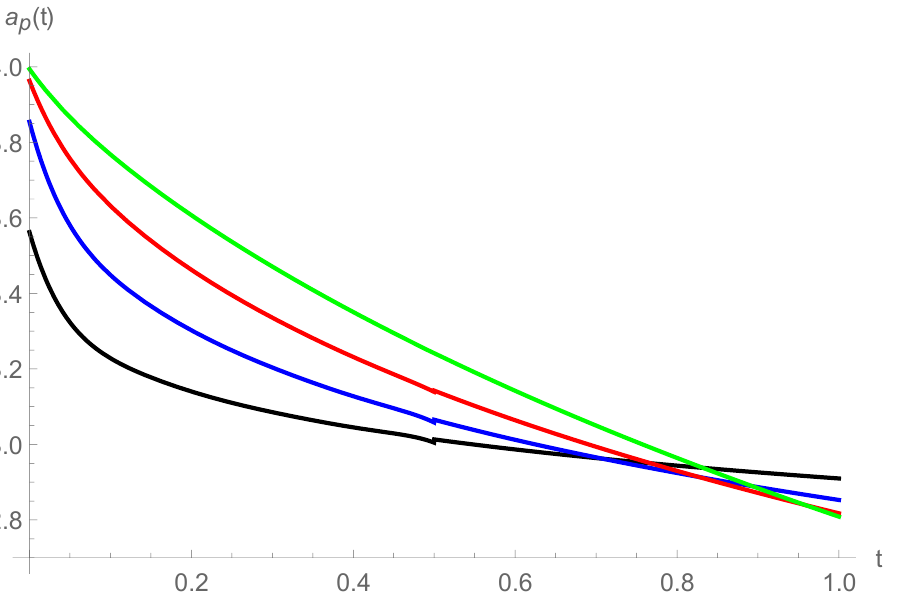
Figure 10. The effect of υ on the distribution of a p ( t ) . Black: υ = 0.2, Blue: υ = 0.4, Red: υ = 0.6, Green: υ =